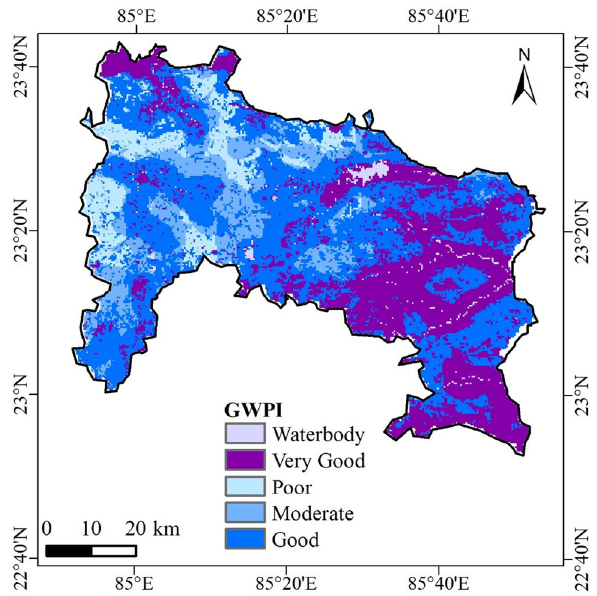
Fig. 10 Groundwater potential map